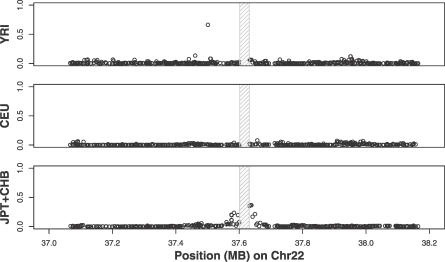
LD Flanking the Deletion VariantLD (r
2) between the deletion locus (shaded box) and flanking Phase I HapMap SNPs is depicted for the YRI, CEU, and JPT + CHB populations.